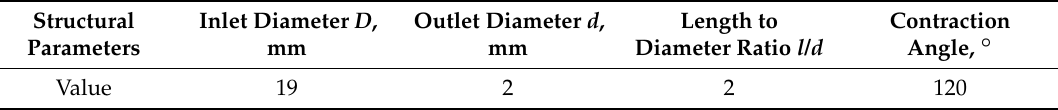
Table 8. Structural parameters of the straight cone nozzle for the experimental study of oil shale breaking.